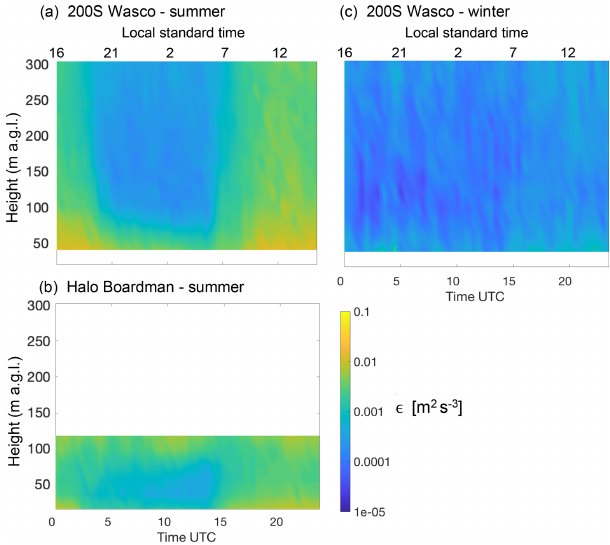
Figure 11. Average diurnal climatology of (cid:15) for the summer (1 June–31 August) from the WINDCUBE 200S at Wasco (a) and the Halo Streamline at Boardman (b) . Average diurnal climatology for the winter (1 December to 28–29 February) from the WIND- CUBE 200S at Wasco (c) . At this site, LST = UTC −